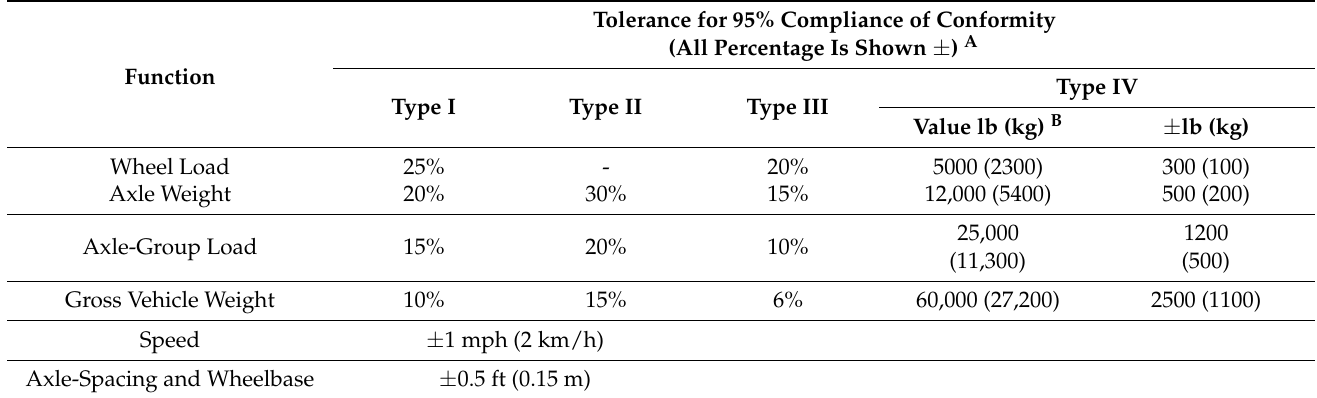
Table 2. Summary table of WIM system requirements as per ASTM E1318 [29].